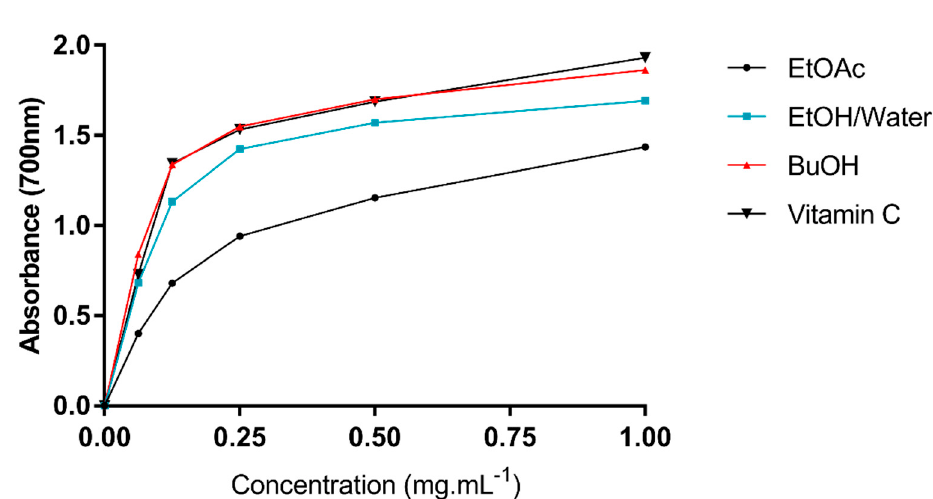
Figure 3. Ferric reducing power of A. arboreum leaf extracts compared to vitamin C as a standard ( n = 3). Table 3. Total antioxidant capacity (TAC), DPPH • , and ABTS • + radical scavenging activities of EtOAc, EtOH/water, and n -BuOH extracts. TAC DPPH • IC 50 ABTS • + IC 50 Extracts/Standard (mg GAE/g Extract) (mg · mL − 1 ) (mg · mL − 1 ) EtOAc 315.865 ± 0.001 c 0.043 ± 0.009 c 0.09 ± 0.017 c EtOH/Water (70/30, v/v ) 597.934 ± 0.002 b 0.037 ± 0.018 b 0.062 ± 0.012 b n -BuOH 661.429 ± 0.001 a 0.031 ± 0.005 a 0.048 ± 0.009 a Gallic acid 433.198 ± 0.002 – – Vitamin C – 0.025 ± 0.015 – Trolox – – 0.051 ± 0.001 Values are the mean of three experiments ± standard deviation (SD) in the same column followed by different letter(s) are significantly different ( p < 0.05) according to Duncan’s multiple range test. a: high activity, b: medium activity, c: low